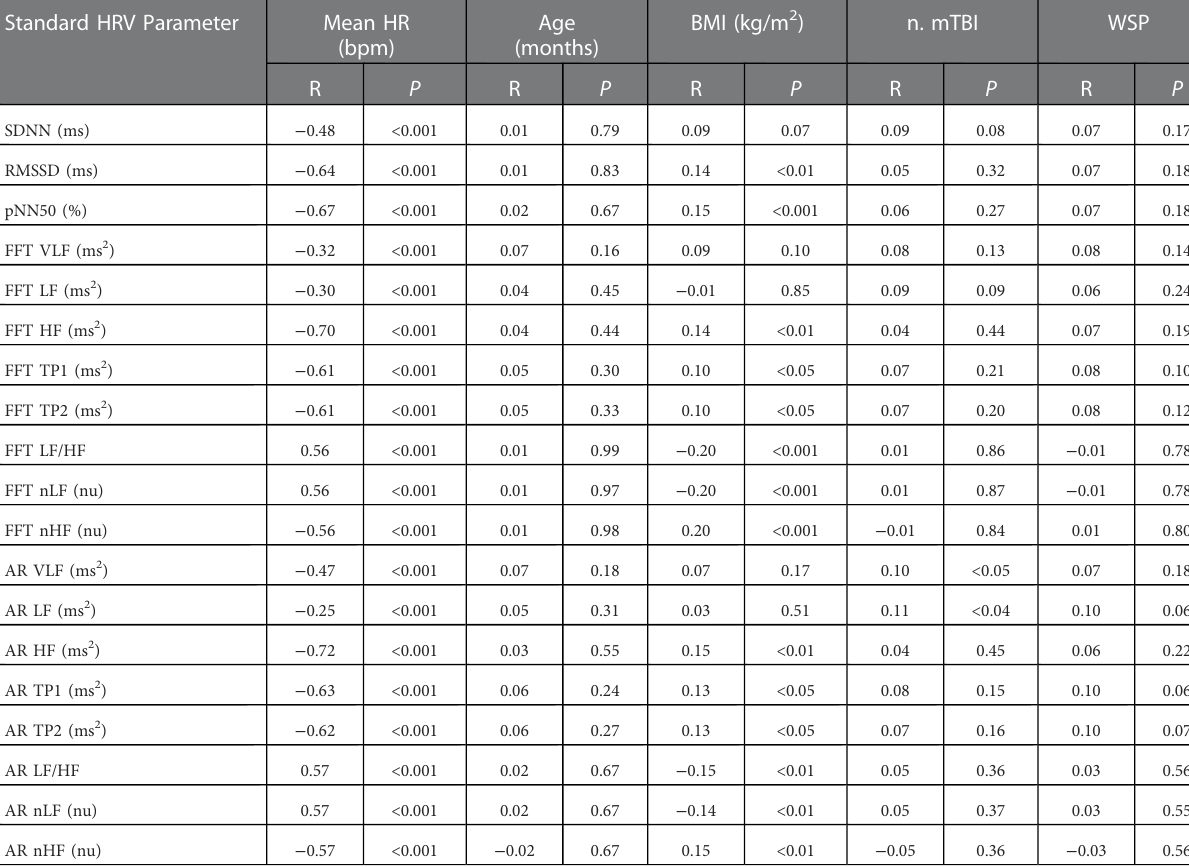
TABLE 2 Correlations of standard time and frequency-domain HRV parameters with mean heart rate, age, body mass index, number of mild traumatic brain injury and weekly sport practice. Standard HRV Parameter